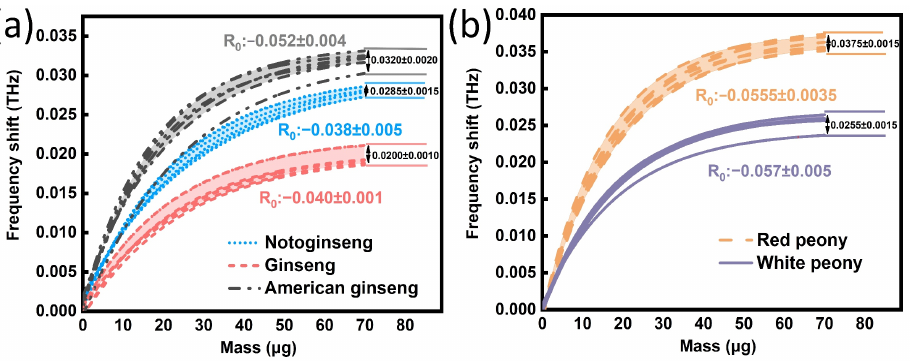
Figure 8. Verification results of method. ( a ) Test results of Panax genus. ( b ) Test results of Paeonia genus.